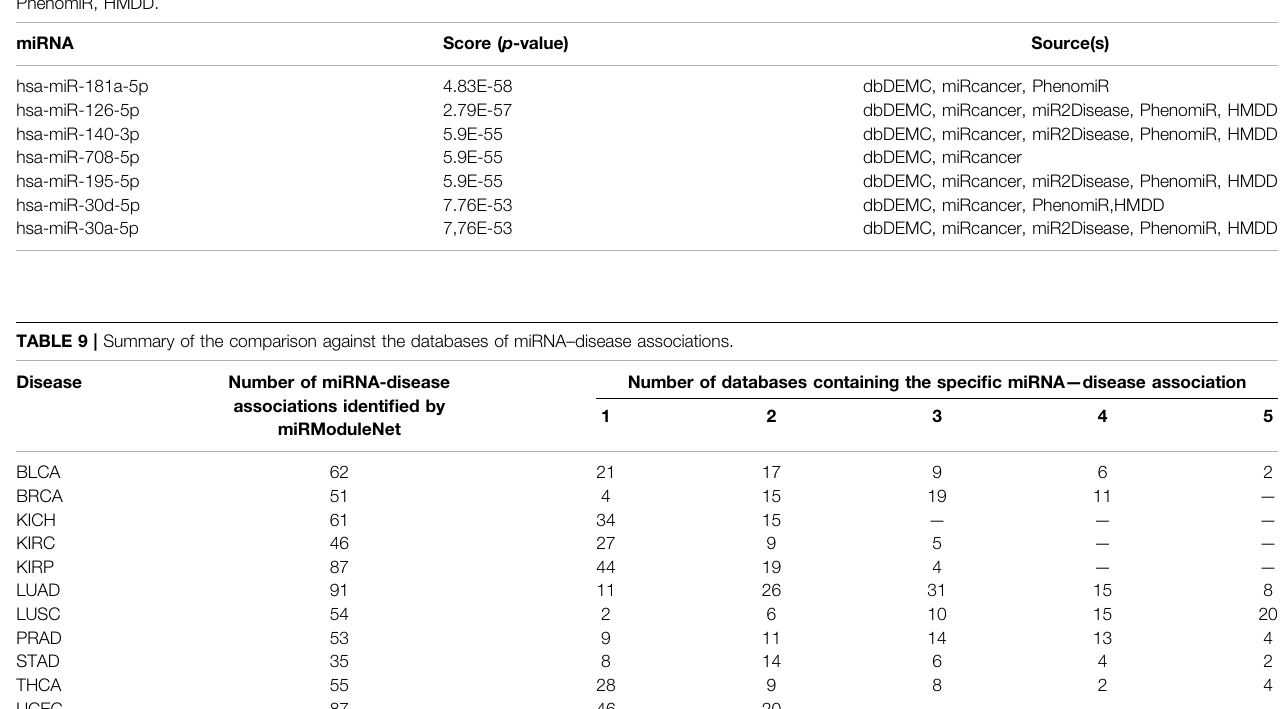
TABLE 8 | Biological validation of the identi fi ed miRNAs for LUSC data by miRModuleNet, against fi ve disease databases, i.e., dbDEMC, miRcancer, miR2Disease, PhenomiR, HMDD. miRNA Score ( p -value)